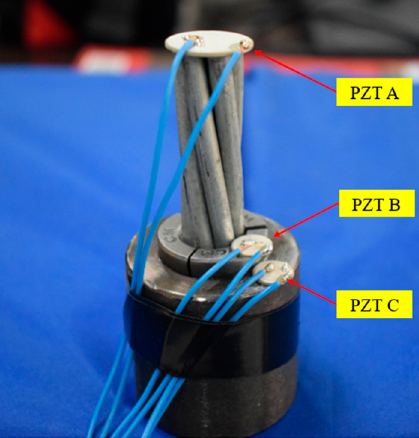
Figure 14. Experimental setup.